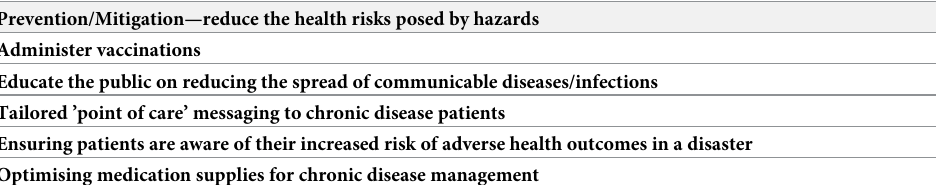
Table 2. Final Consensus on five roles pharmacists are capable of undertaking in the prevention phase of a